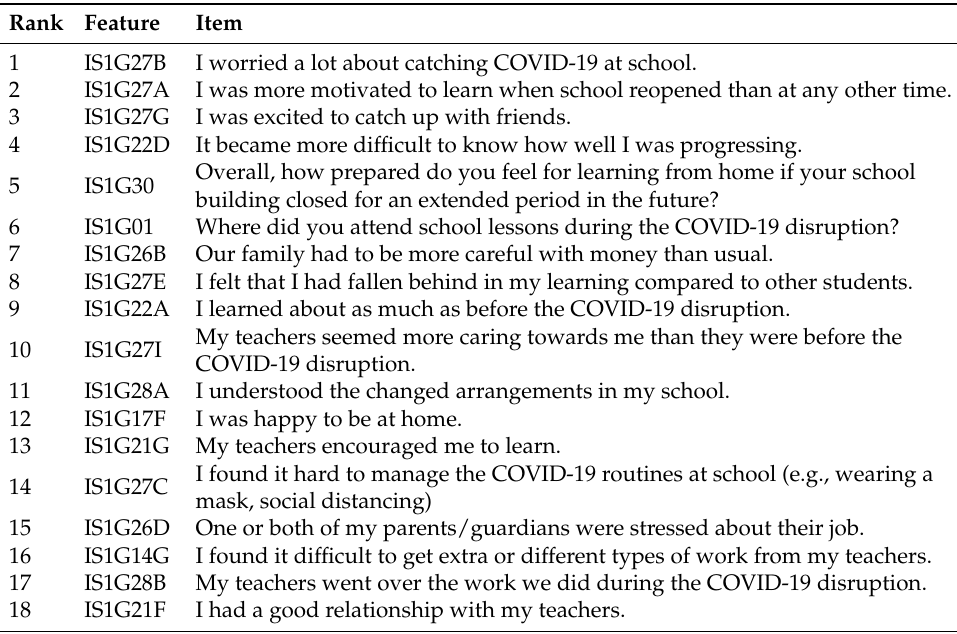
Table 5. Top 10% most influential variables for the DMI